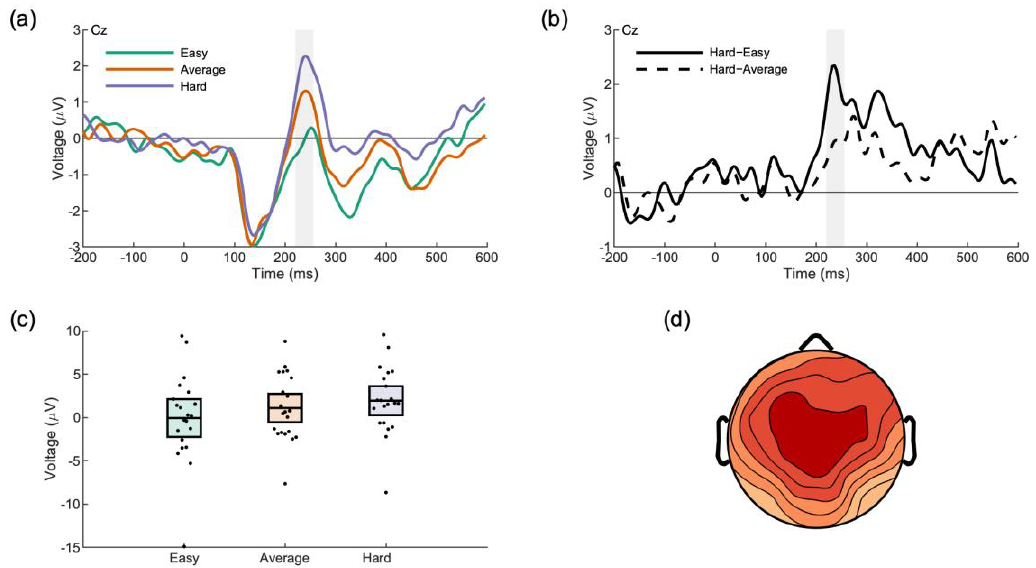
Figure 5. Neural response to opponent faces distinguishes opponent difficulty. ( a ) A prominent positivity is noted in response to each face. The shaded area shows the region of our exploratory analysis. ( b ) Difference waves showing the time range of the effect. ( c ) Mean component scores for each opponent. ( d ) Scalp distribution of the P3a difference between the hard opponent and the easy opponent.